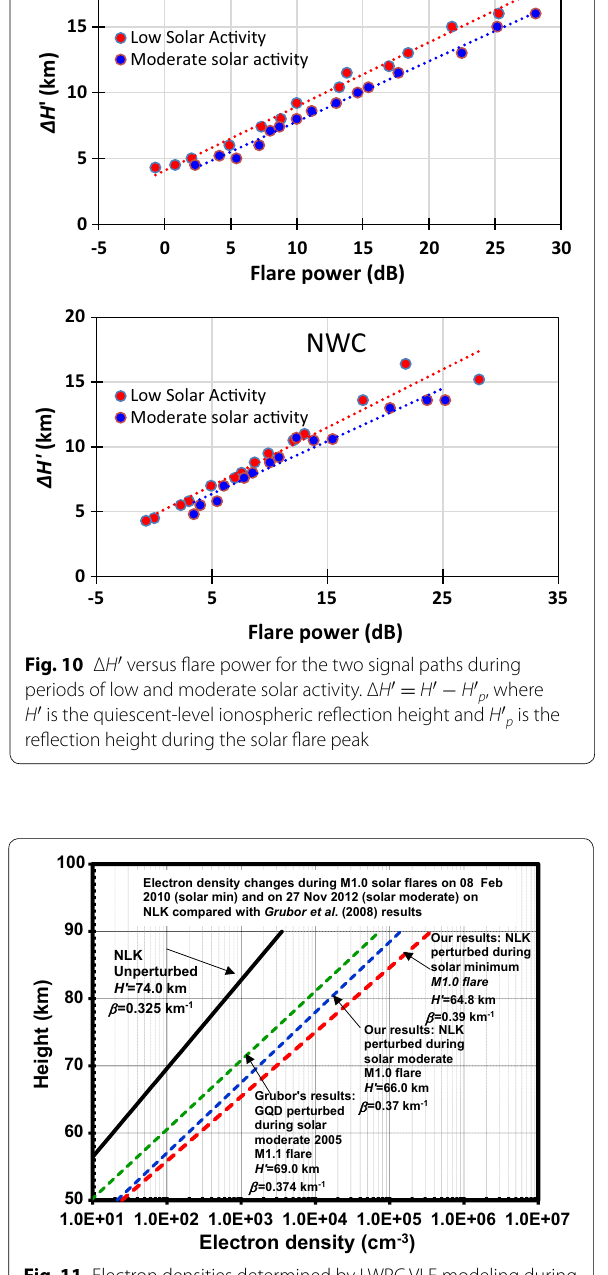
Fig. 11 Electron densities determined by LWPC VLF modeling during the M 1.0 solar flare of February 08, 2010 (red dashed line—solar mini- mum), and of November 27, 2012 (blue dashed line—moderate solar activity), compared with normal unperturbed electron densities (solid black line) for NLK to Suva path. Also shown is comparison of electron density plot of Grubor et al. (2008) results (green dashed line) for an M 1.1 flare during a period of moderate solar